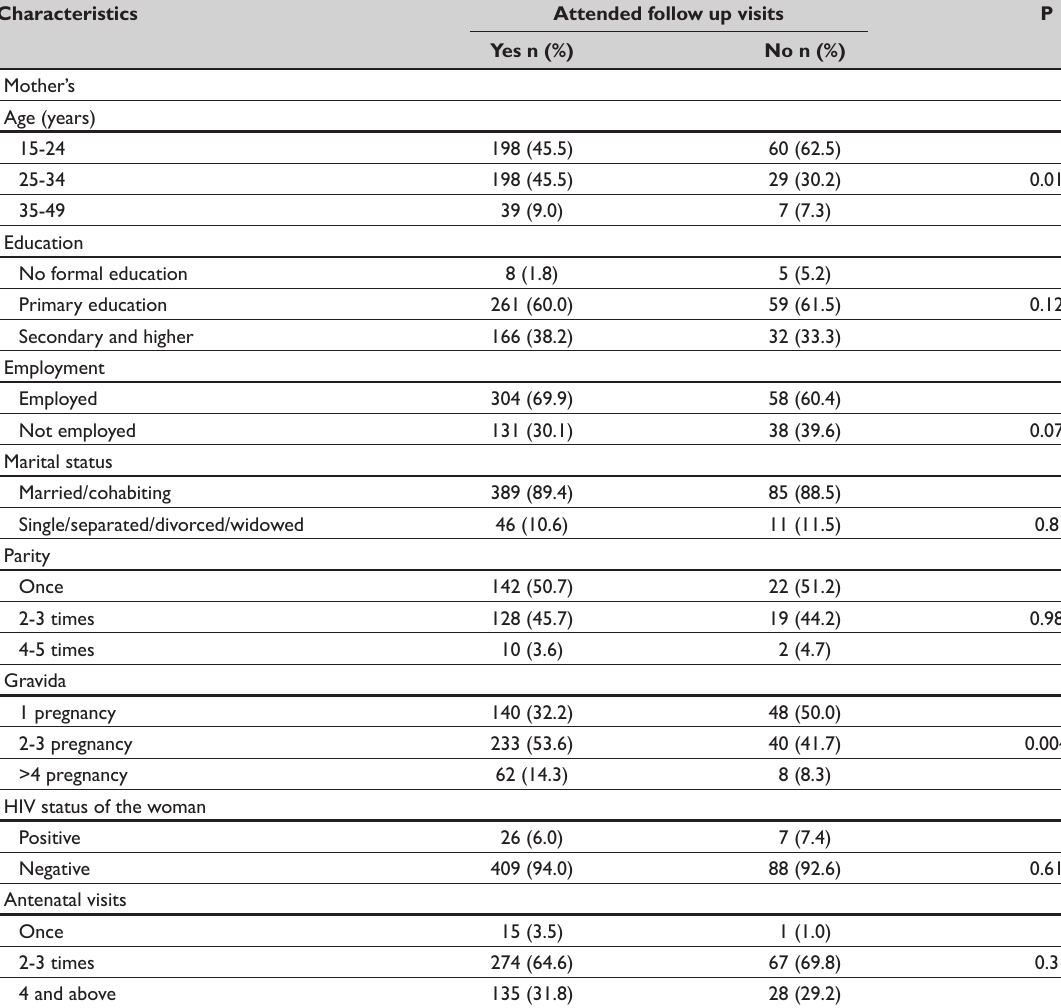
Table 1: Comparison of socio demographics characteristics of 441 women attended for follow up at least once and 95 women who did not come back at all